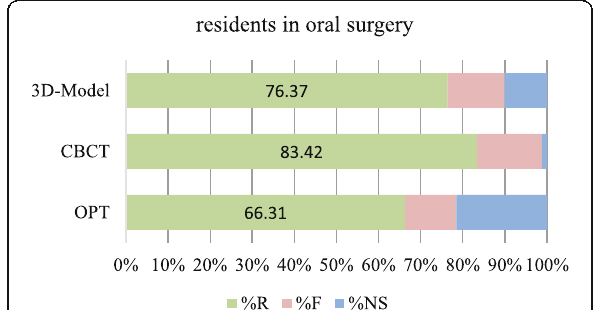
Fig. 1 Accuracy of diagnostic answers from residents in oral surgery (R right, F false, NS not sufficient)